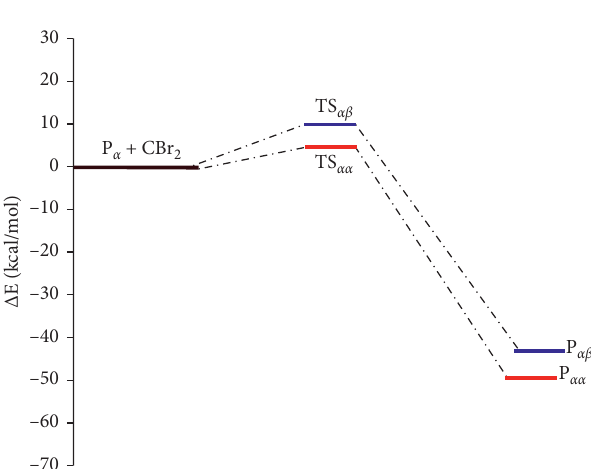
Figure 6: Energy profile of reaction between P